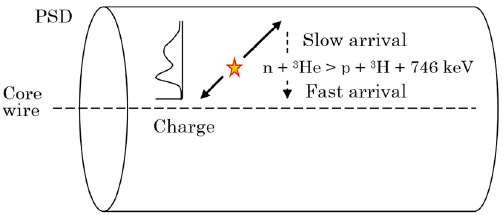
Fig. 8. Trajectories of a triton and proton after the reaction between a neutron and 3 He.